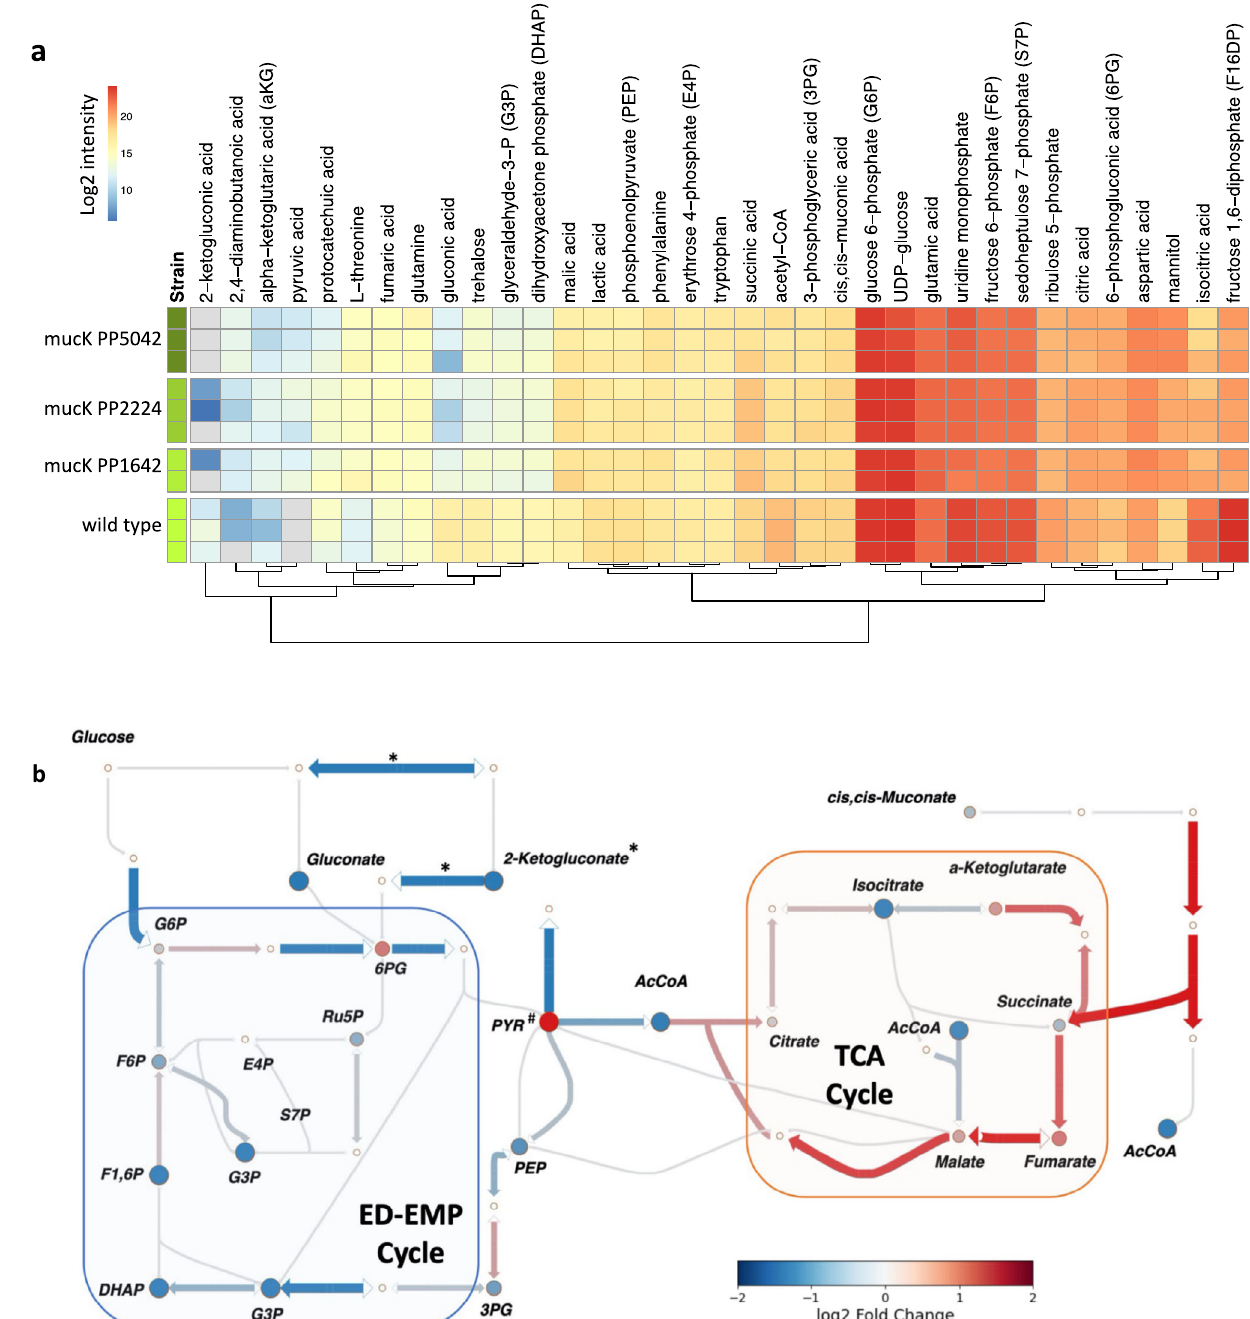
muconatecatabolismpathwaysofmucKPP5042andfoldchangescomparedtothe wild-typestrain.Circlesindicatemetabolitesandarrowsindicateproteinsdetected by SRM. Symbols indicate protein detection: * detected in the wild type but not detectedinthemucKsamplesand#detectedinthemucKbutnotinthewildtype. Source data are provided as a Source data fi